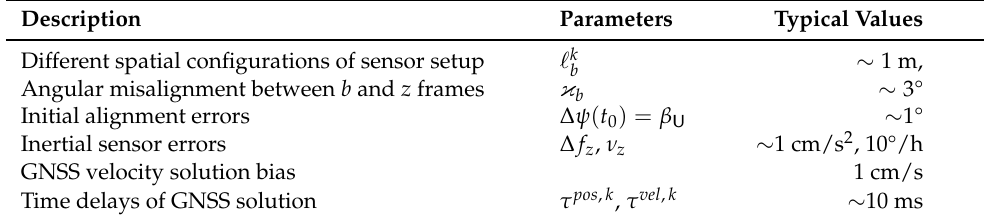
Table 3. Simulated